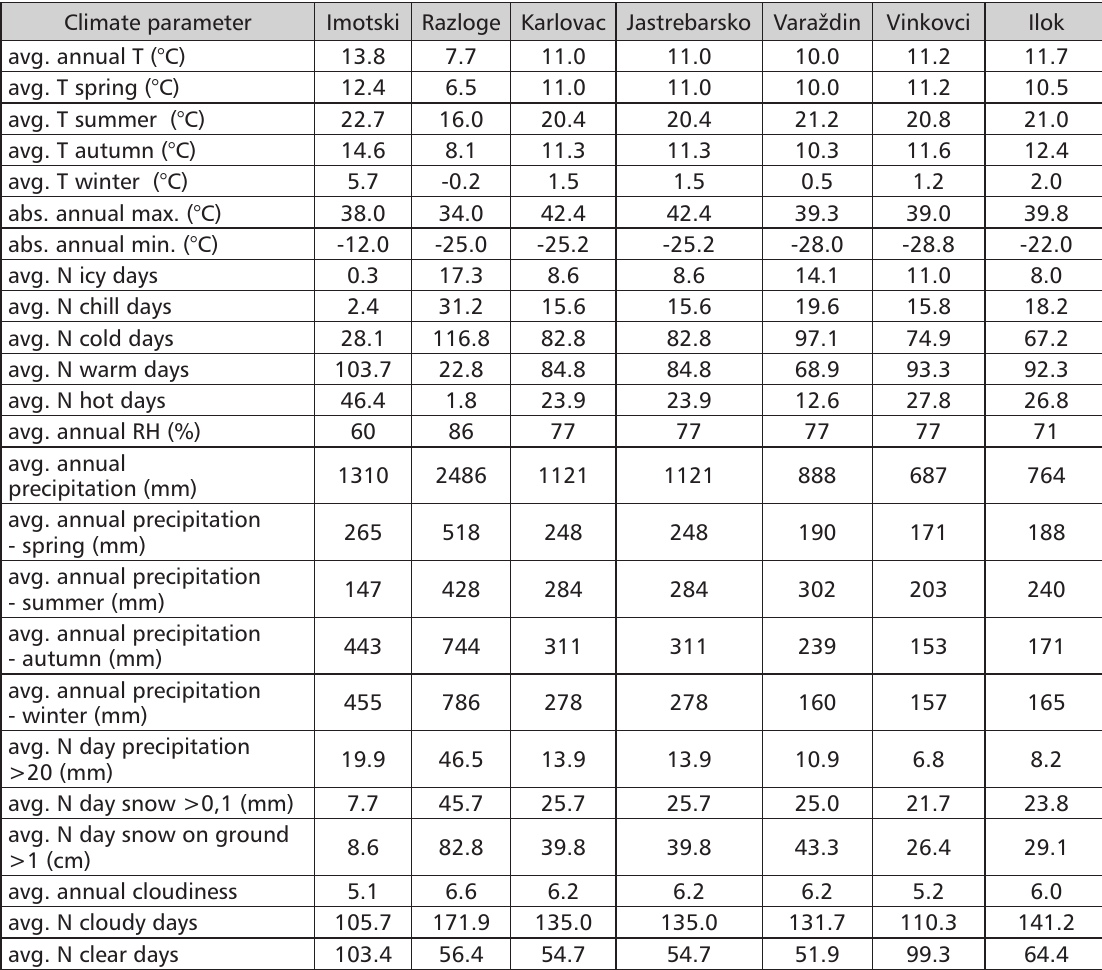
Climate parameters in the settlements included in the research